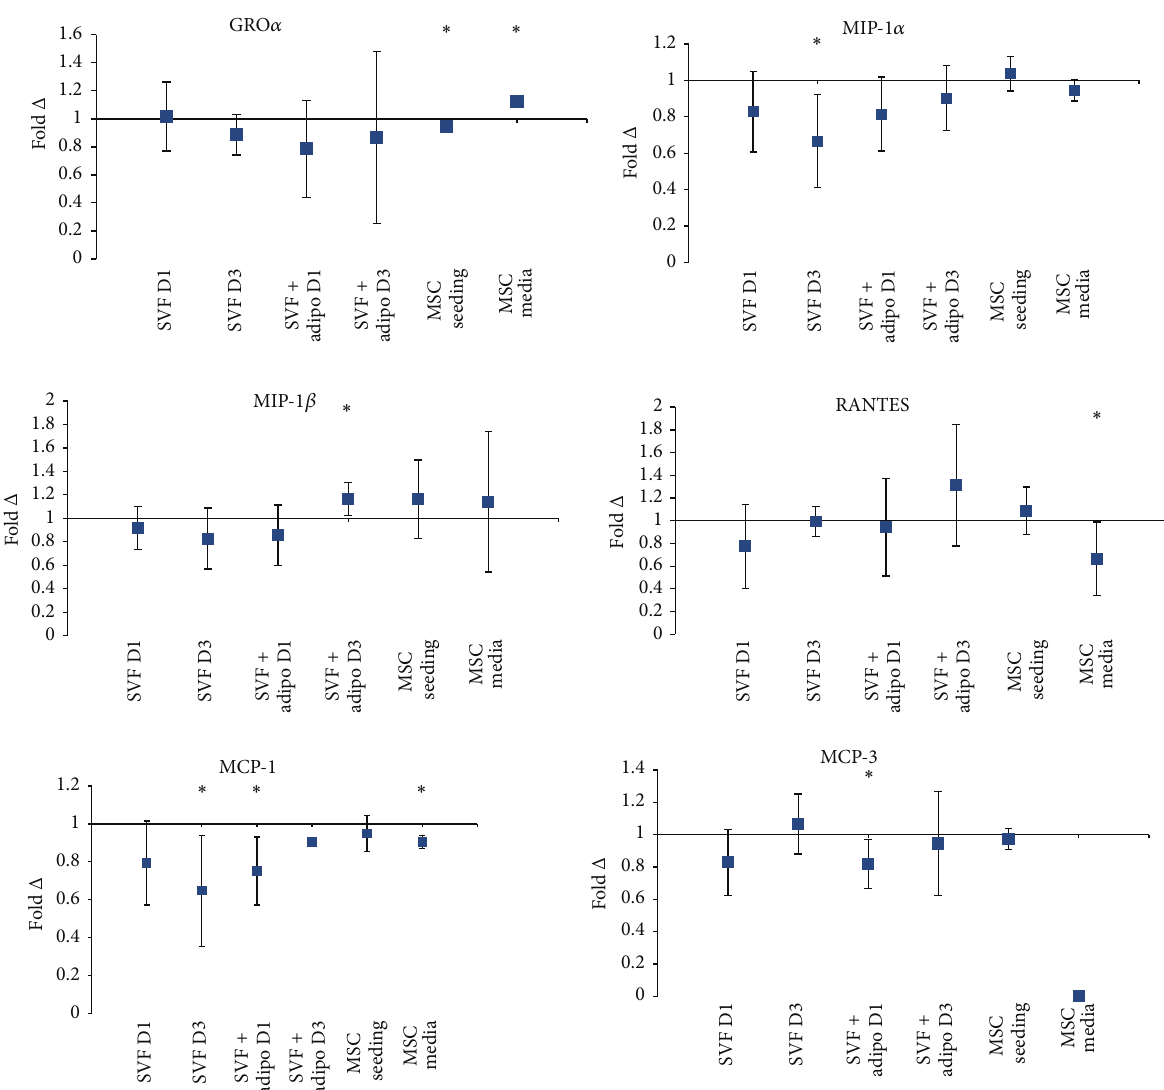
Figure 7: Fold change in concentration of chemokines detected across the experiments. Average fold change in concentration ( 𝑛 = 3 ) ± upper and lower confidence intervals at 95% ( 𝑦 -axis). Conditions ( 𝑥 -axis): stromal vascular fraction on day 1 (SVF D1), stromal vascular fraction on day 3 (SVF D3), stromal vascular fraction plus mature adipocytes on day 1 (SVF + adipo D1), stromal vascular fraction plus mature adipocytes on day 3 (SVF + adipo D3), seeding experiment with purified MSCs (MSC seeding), and media change experiment with purified MSCs (MSC media). Conditions were all cultured in either standard culture media or HA media. Cytokines with a fold change less than one indicate a decrease in concentration with HA media treatment, and a fold change greater than one indicates an increase in the cytokine with HA treatment. Chemokine ligand-1 (CXCL-1) aka growth-regulated peptide alpha (GRO 𝛼 ), CC-Chemokine ligand-4 (CCL-4) aka macrophage inflammatory protein-1 beta (MIP-1 𝛽 ), CC-Chemokine ligand-5 (CCL-5) aka regulated on activation normal T cell expressed and secreted (RANTES), CC-chemokine ligand-2 (CCL-2) aka monocyte chemotactic protein-1 (MCP-1), CC-chemokine ligand-7 (CCL-7) aka monocyte chemotactic protein-3 (MCP-3), and CC-chemokine ligand-3 (CCL-3) aka macrophage inflammatory protein-1-alpha (MIP-1 𝛼 ). MCP-3 was not detected across all biological replicates in the MSC media condition. MCP-1 was only detected in one of three biological replicates in the SVF + adipo D3